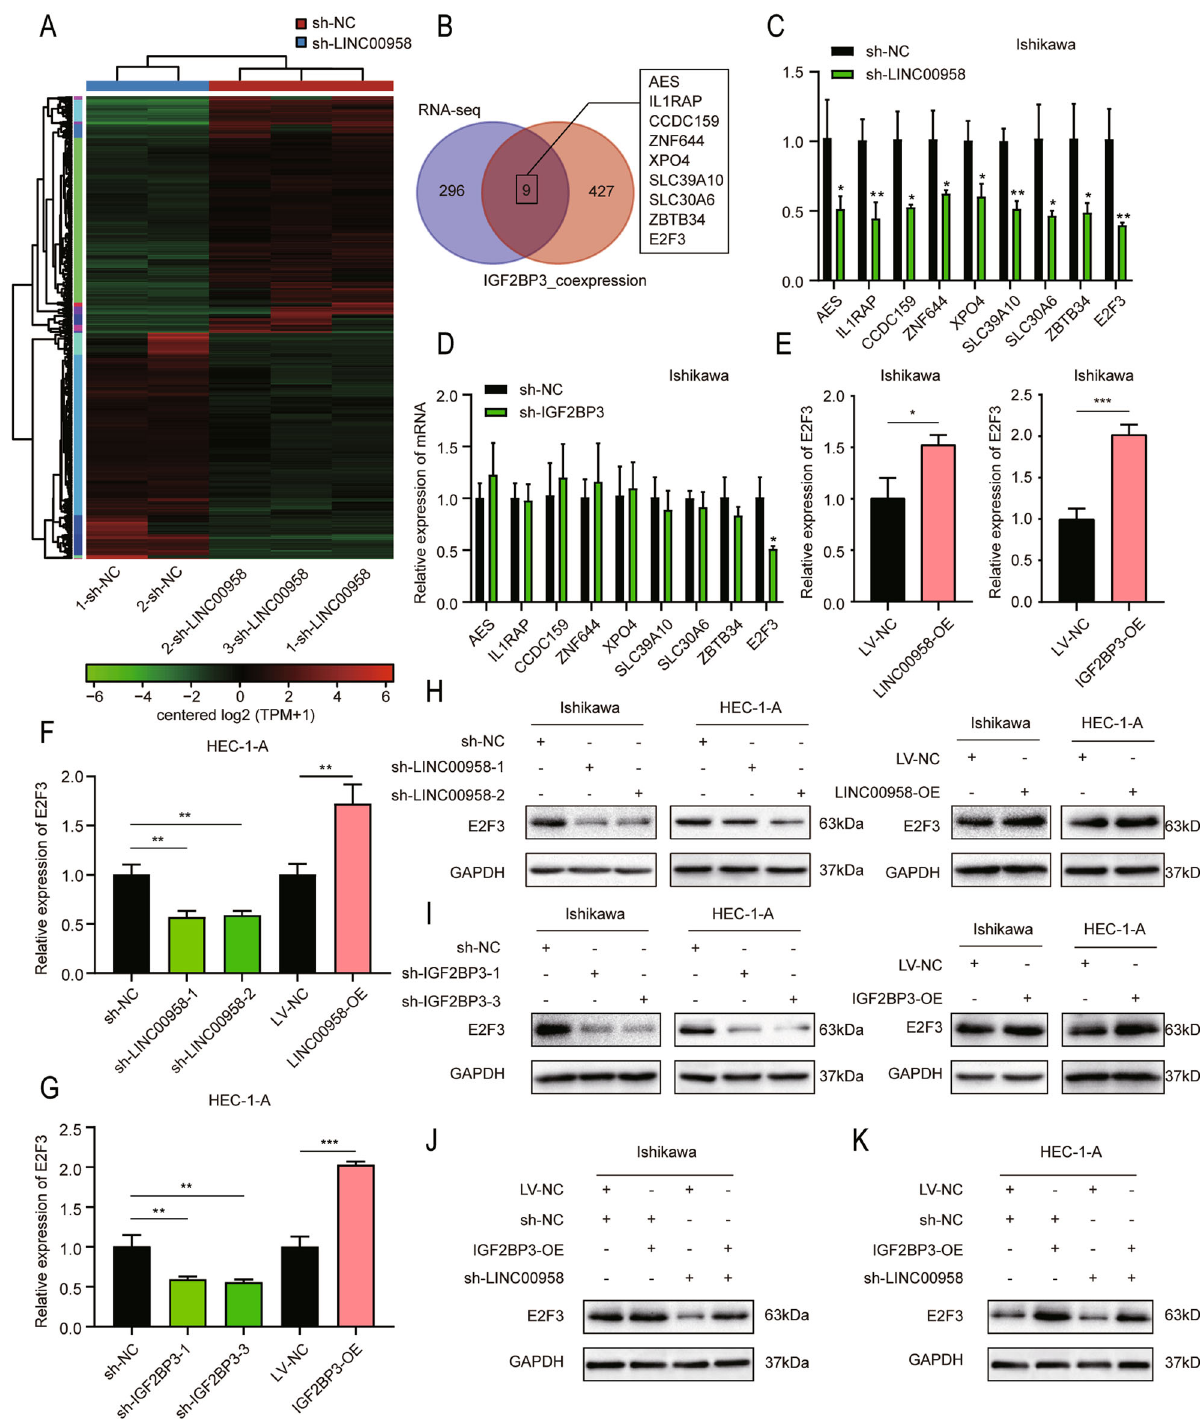
Fig. 5 IGF2BP3 upregulated E2F3 expression by interacting with LINC00958 in EC cells. A Heatmap of RNA-seq displaying the differentially expressed genes in LINC00958-silenced Ishikawa cells and LINC00958-nonsilenced cells. B Venn diagram showing nine potential downstream mRNAs by overlap of RNA-seq and coexpressed genes with IGF2BP3 in UCEC obtained from TCGA dataset. C , D RT – qPCR assays showed the expression of the nine potential downstream mRNAs in LINC00958-silenced ( C ) and IGF2BP3-silenced ( D ) Ishikawa cells. E RT – qPCR con fi rmed the expression of E2F3 in both LINC00958-overexpressing and IGF2BP3-overexpressing Ishikawa cells. F~I RT – qPCR and western blot assays showed the expression of E2F3 in LINC00958 – overexpressing and LINC00958-silenced HEC-1-A cells ( F , H ) as well as IGF2BP3 – overexpressing and IGF2BP3-silenced HEC-1-A cells ( G , I ). J and K Western blot assays revealed the expression of E2F3 in Ishikawa ( J ) and HEC-1-A cells ( K ) stably transfected with negative control or LINC00958-silenced lentivirus and cotransfected with IGF2BP3 – overexpressing or corresponding control lentivirus. * P < 0.05, ** P < 0.01, *** P < 0.001. Data, mean ± S.D. All experiments were independently repeated with at least three replicates.